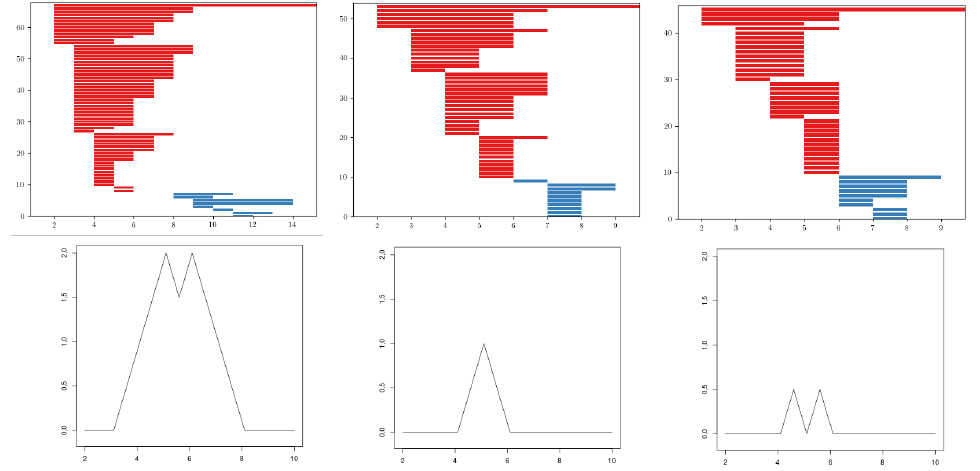
( 18 ) from cEE, cNT, and dWL, respectively. Figure 8. An example of barcodes and its landscapes λ sub 0 Note that the domain of the landscapes of cNT and dWL are the same, but the area of cNT is greater, since in that domain the 18 bars are the same, while for dWL the bars vary.